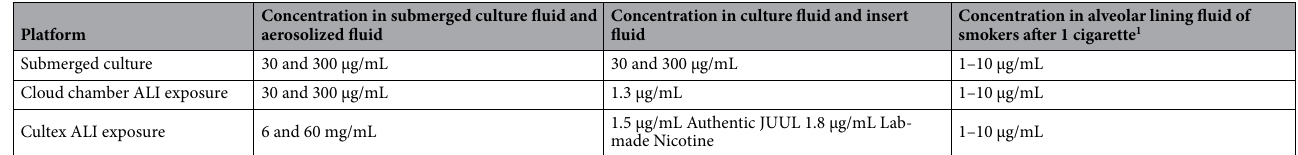
Table 1. Nicotine concentrations across the in vitro platforms compared to nicotine concentrations in alveolar lining fluid of human smokers 1 . 1 Ranges are taken from references in the 57,58 .